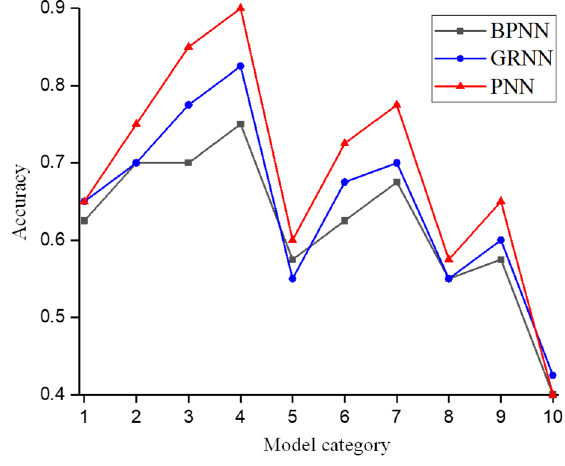
Figure 10. Accuracy comparison of different input models and different classifiers. Table 2. Comparison of predicted optimal results of different classifiers.